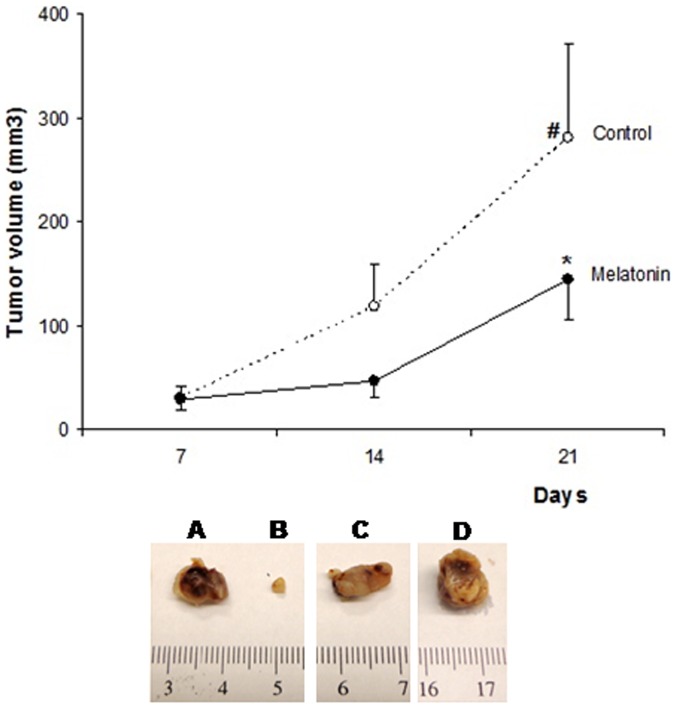
Antitumor effects of melatonin on mammary tumor growth.Melatonin reduced the tumor growth in breast cancer nude mice. Each point in the curves represents the mean ± SD (control n = 8; melatonin n = 5). The melatonin inhibited tumor growth, *p<0.05 vs Control. # Significant increase in tumor volume on control group at 14 and 21 after tumor implantation and initiation of treatment with vehicle (p<0.05). Detail: Representative samples of mammary tumors developed by MDA-MB-231 cells implantation on the right flank of mice. A, B. Melatonin treated mammary tumors, B. Mammary tumor which regressed with melatonin treatment. C, D. Vehicle treated mammary tumors.